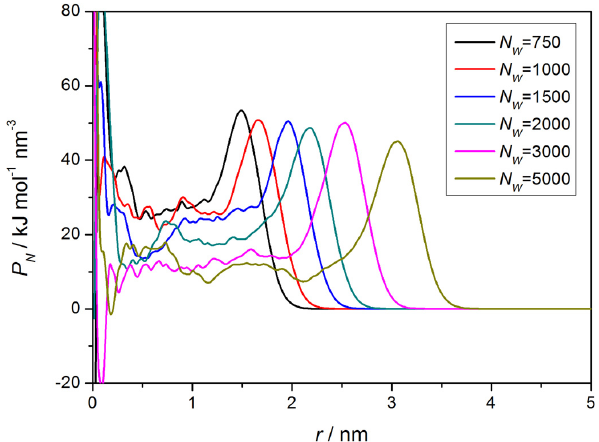
Fig. 4. Normal component of the Irving-Kirkwood pressure tensor and 1P N (r) curves in systems